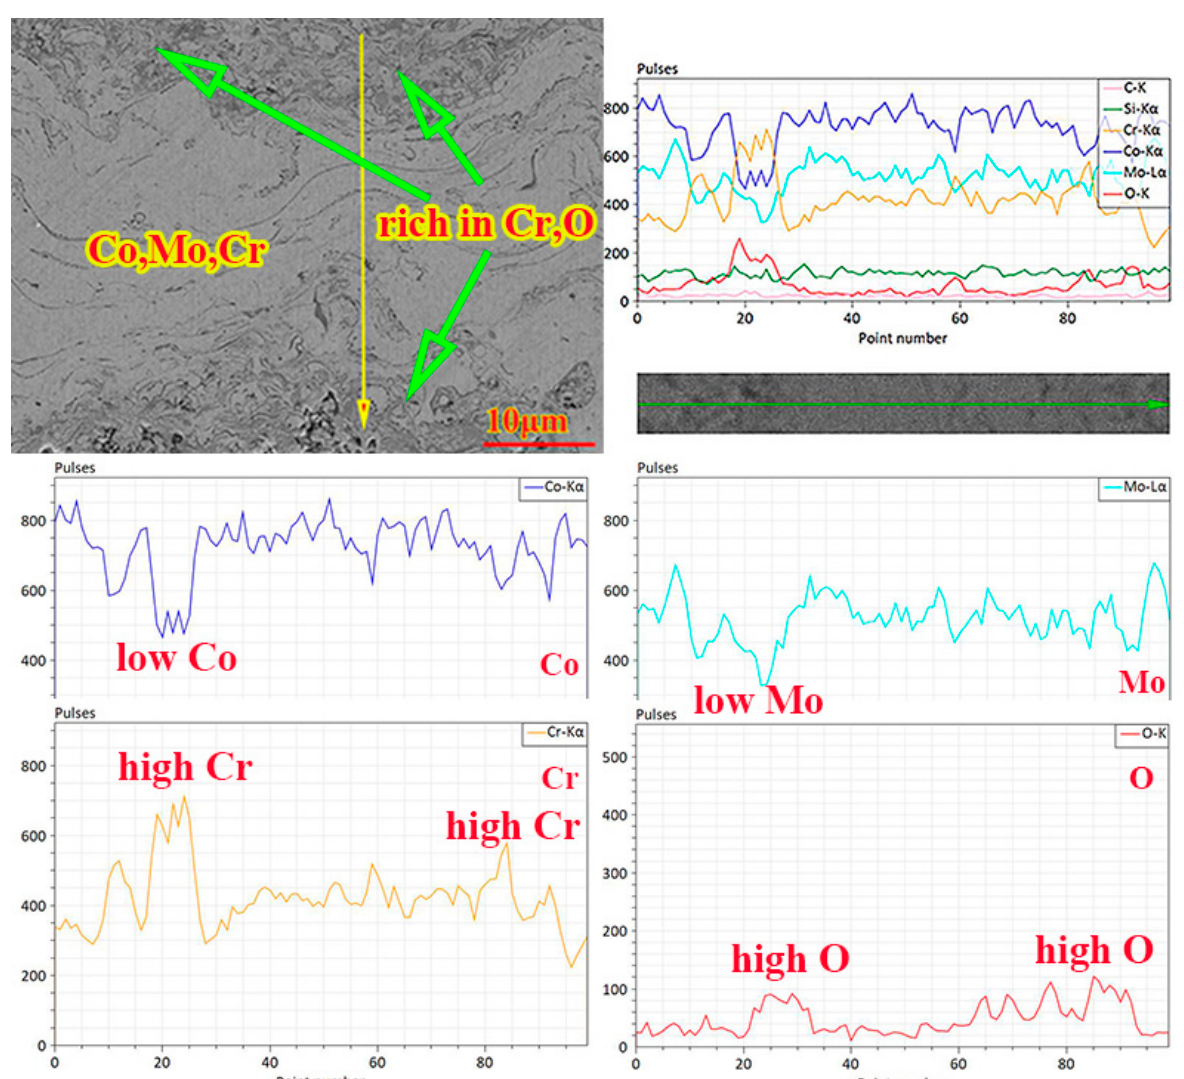
Figure 5. Linear scanning result of cross-section of coating annealed for 5 h.